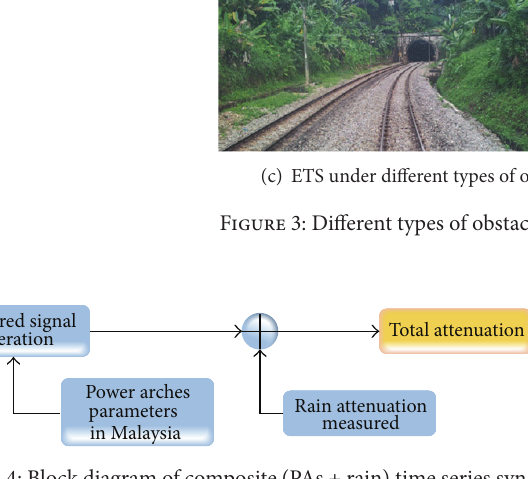
Figure 4: Block diagram of composite (PAs + rain) time series syn- thesizer.